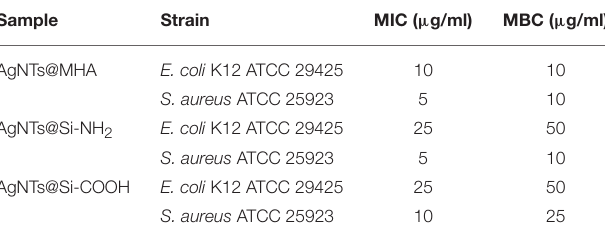
TABLE 2 | The minimum inhibitory concentration (MIC) and minimum bactericidal concentration (MBC) of AgNTs@MHA, AgNTs@Si-NH 2 , and AgNTs@Si-COOH toward E. coli K12 ATCC 29425 and S. aureus ATCC 25923. Sample Strain MIC ( µ